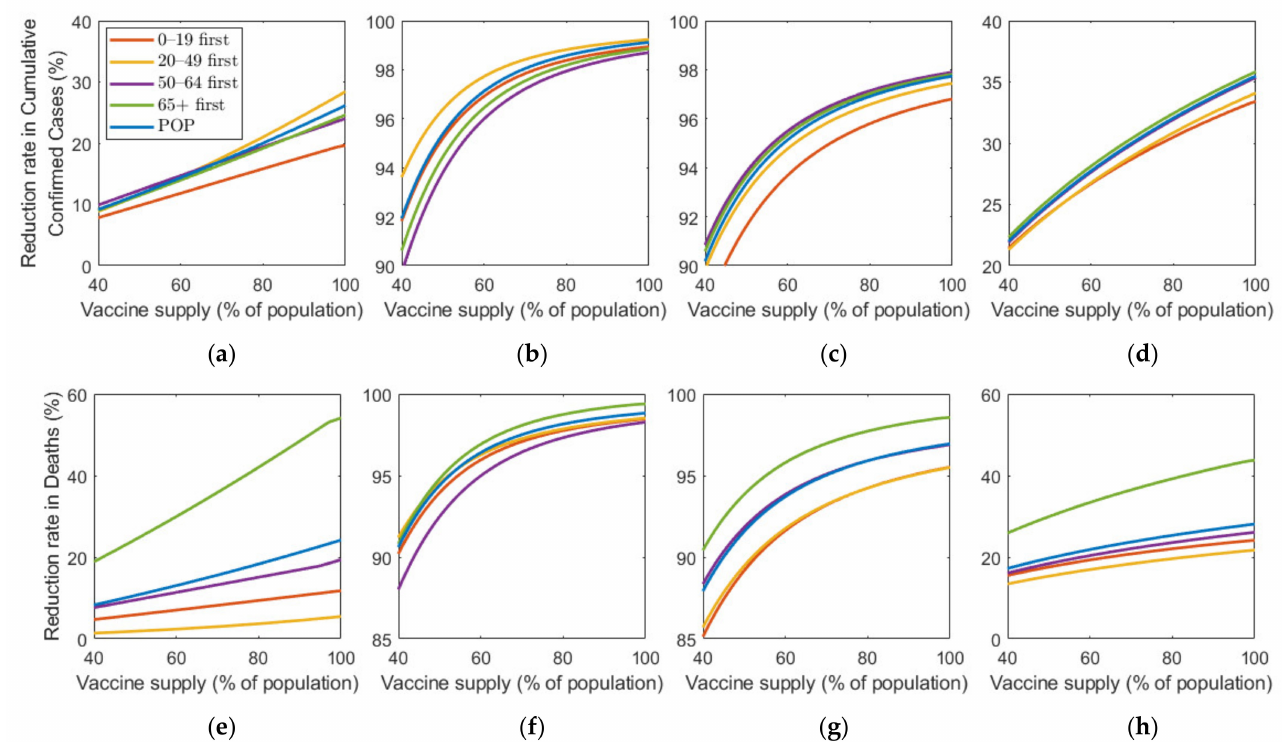
Figure 8. Impact of vaccination coverage rate on the reduction in cumulative confirmed cases and deaths for different SD levels: ( a , e ) 0, ( b , f ) 1, ( c , g ) 2, and ( d , h )